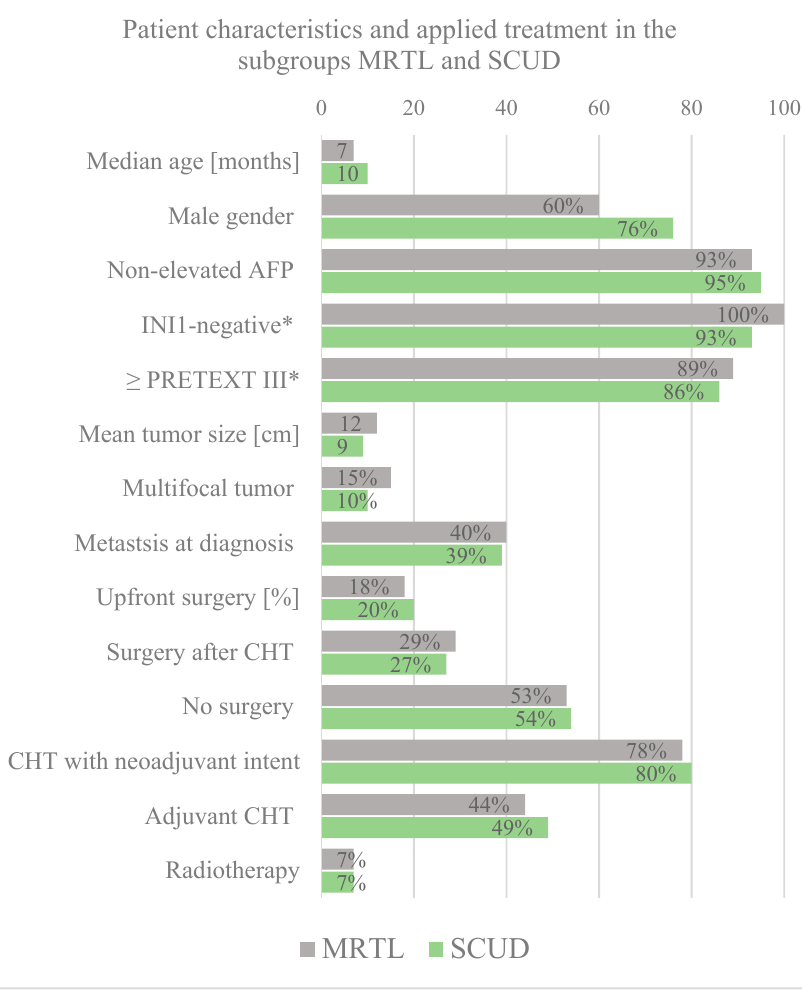
Figure 3. Overview of patient characteristics in the subgroup of MRTL and SCUD. * Percentages of those with available data on this